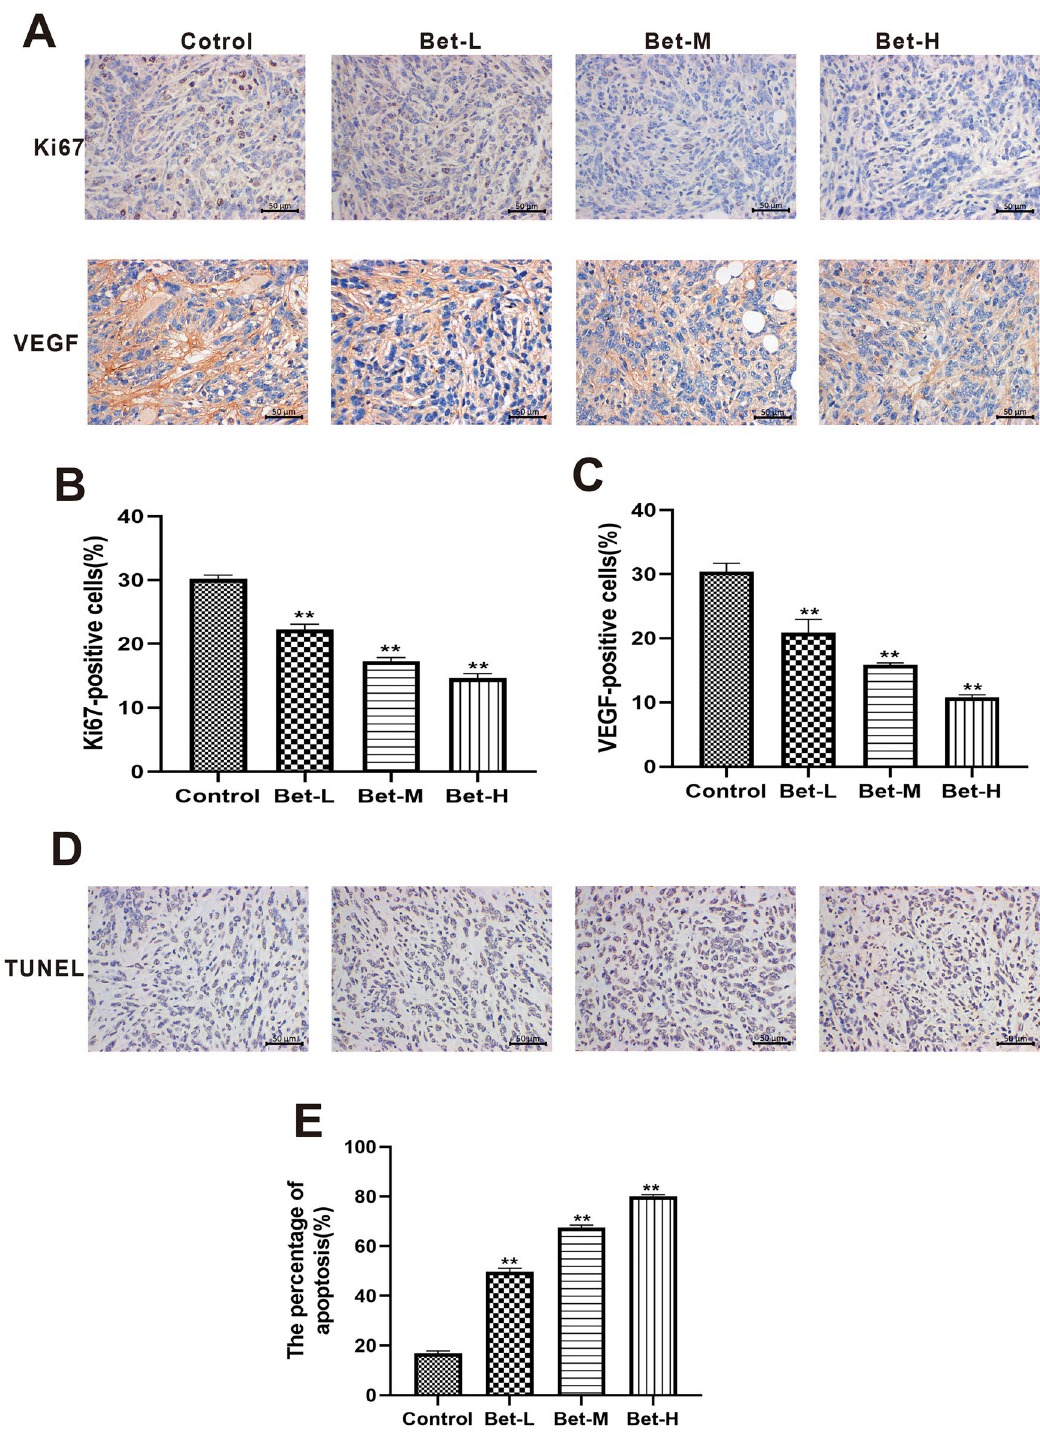
Figure 8. The effect of betulinaldehyde on the expression of proliferation and apoptosis markers in tumor tissues. ( A ) Representative IHC images of VEGF and Ki67 of the tumors. ( B , C ) Quantification analysis of immunoreactive cells for VEGF and Ki67. Data are presented as mean ± SD (n = 4). ( D ) TUNEL analysis image at 3 weeks after transplantation. ( E ) Quantified TUNEL positive apoptotic cells count. All values are expressed as the mean ± SD ( n = 4). Comparisons among multiple groups were performed using one-way analysis of variance. The differences between control and treatment groups were analyzed using LSD multiple comparison test. * P < 0.05, ** P < 0.01 versus control group, # P < 0.05, ## P < 0.01 versus Bet group (Bet-L = betulinaldehyde [50 mg/ kg]; Bet-M = betulinaldehyde [100 mg/kg]; Bet-H = betulinaldehyde [200 mg/kg]. Scale bar, 50